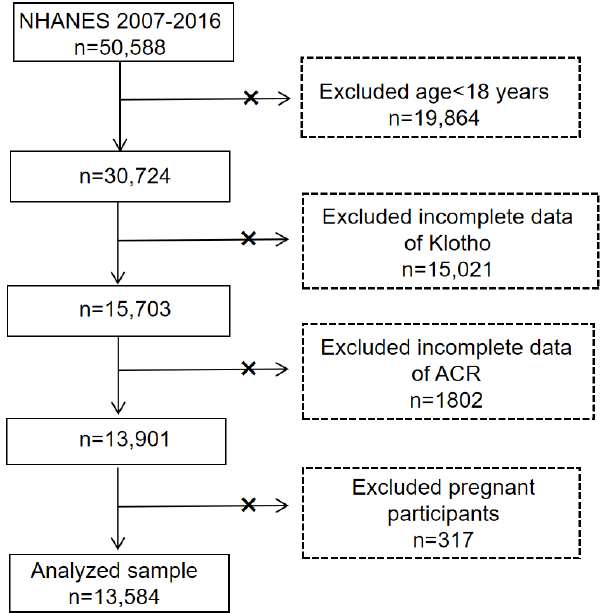
Figure 1. Flowchart of the participants’ selection from NHANES 2007–2016. Abbreviations: ACR = albumin–to–creatinine ratio.